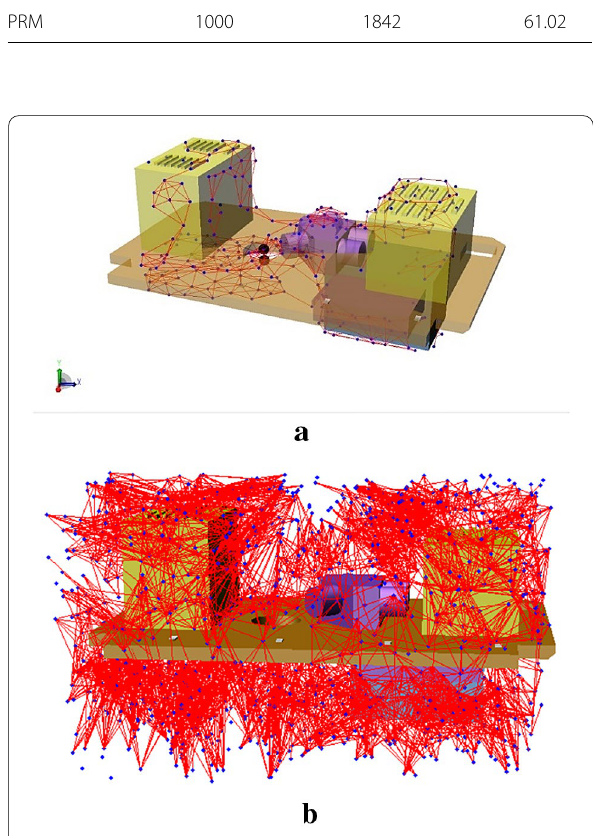
Figure 10 Roadmaps used in the first scenarios: a roadmap constructed by the UOBPRM, b roadmap constructed by the original PRM